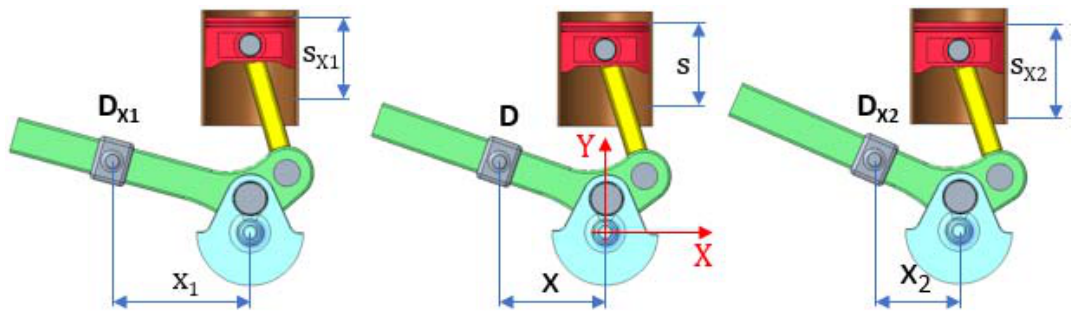
Figure 5. Piston stroke influence with modifying the pivot point on horizontal direction.